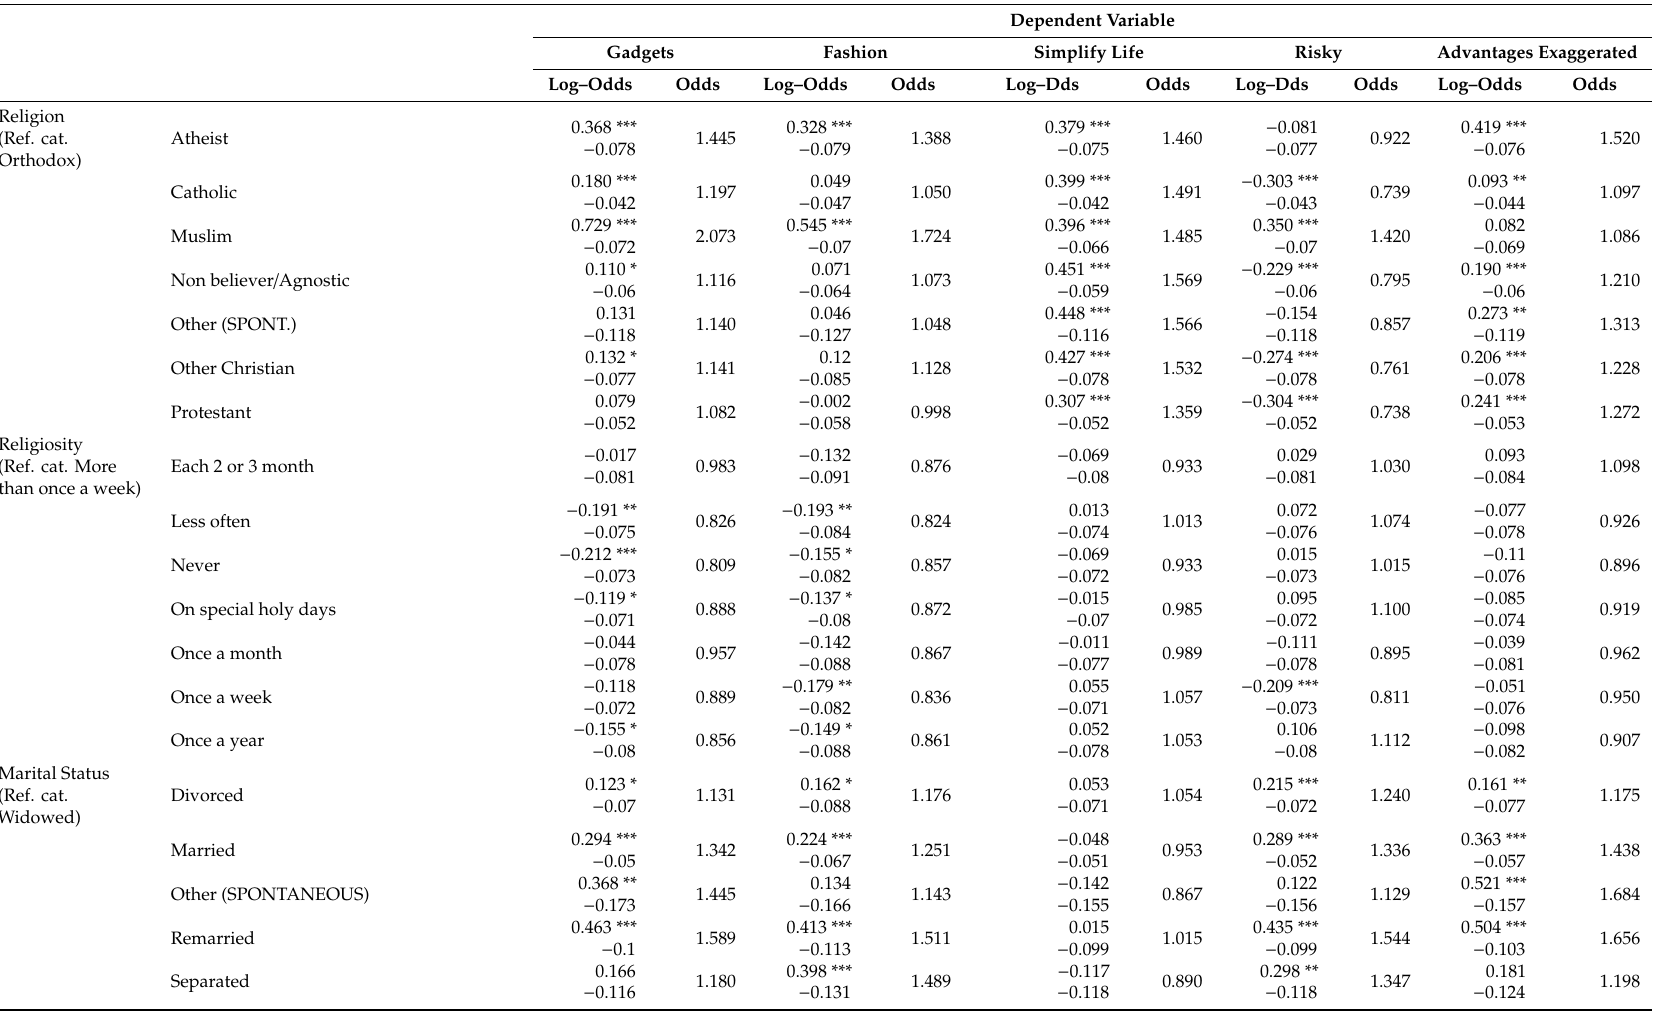
Table 6. Logistic regression